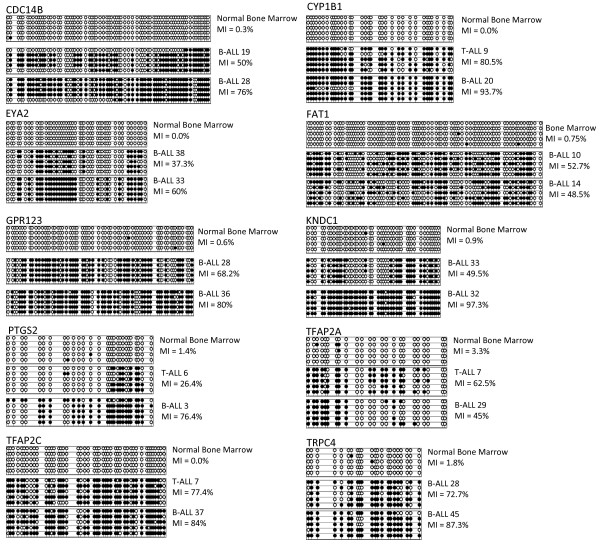
Methylation assessed by sequencing. Representative results of cloning and sequencing of ten genes. COBRA PCR products were cloned into PGem T-easy vector and colonies were picked and inserts sequenced. Each line is representative of an individual allele. Each circle represents a single CpG dinucleotide, filled circles represent a methylated CpG dinucleotide whereas clear circles represent an unmethylated CpG dinucleotide. The MI was calculated as a percentage using the equation; number of CpG dinucleotides methylated/total number of CpG dinucleotides sequenced x 100. Sequencing of the DNA from control bone marrow shows no or very infrequent methylation, with MIs all below 3.5%. For each gene two samples for which COBRA analysis detected hypermethylation and two for which it did not were sequenced. The figure shows control bone marrow and two methylated samples for each gene. The sequencing results correlate with the COBRA detected methylation.